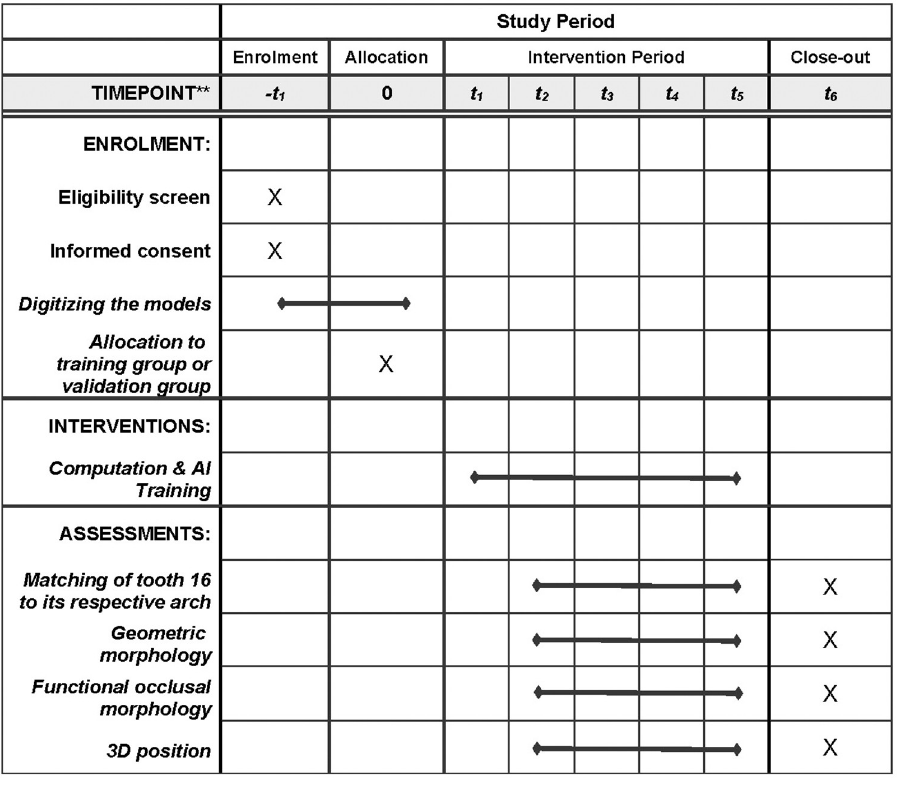
Fig 1. SPIRIT diagram showing the schedule of enrollment, allocation, interventions, and assessments of this study. –t 1 = baseline assessment (before randomization), 0 (t 0 ) = randomization, t 1 = after randomization, t 2 = 25% of collected models learnt by AI, t 3 = 50% of collected models learnt by AI, t 4 = 75% of collected models learnt by AI, t 5 = 100% of collected models learnt by AI, t 6 = the whole study is completed.